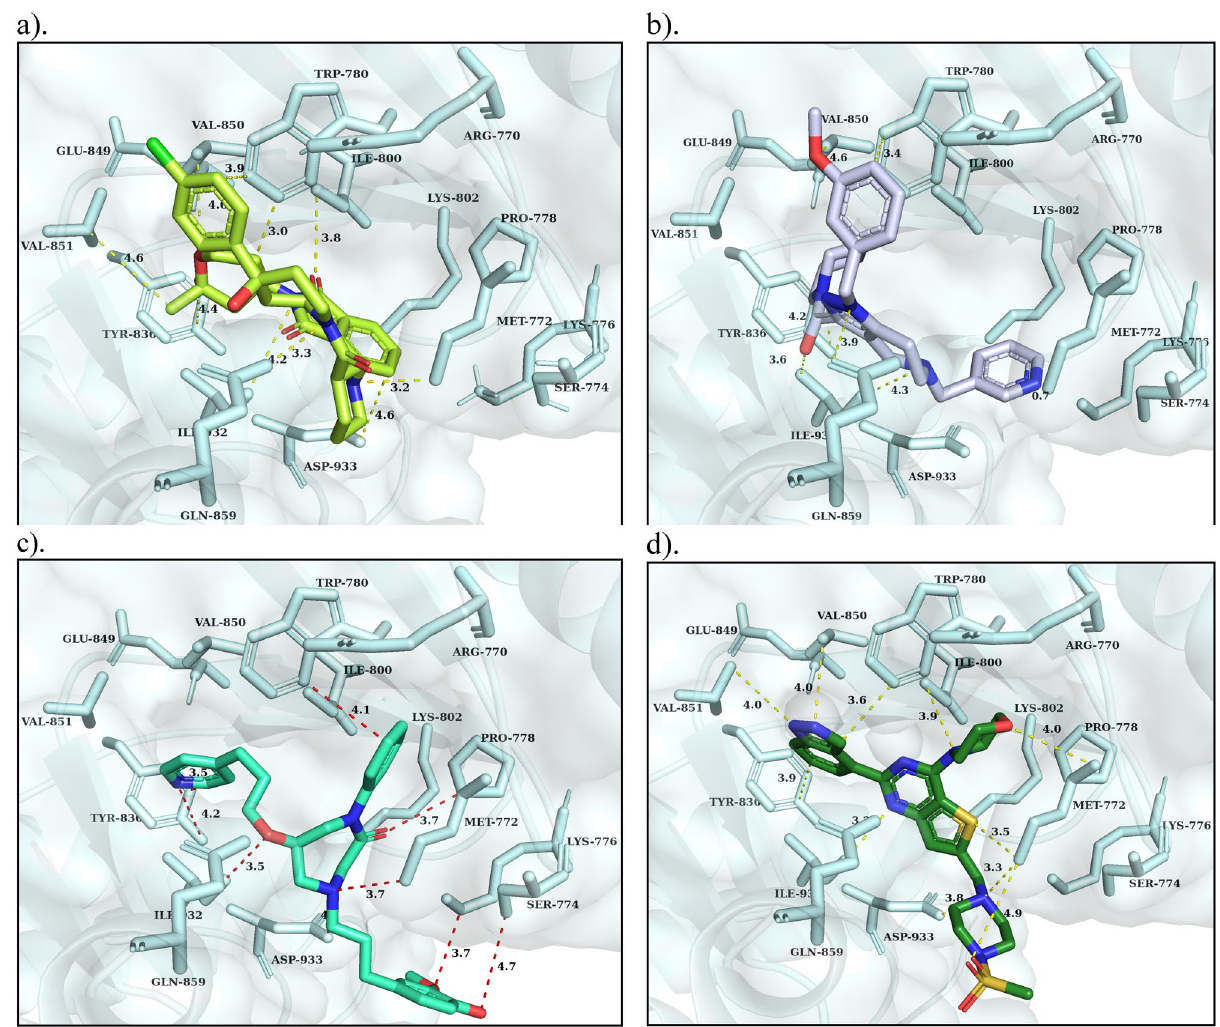
Figure 7. . Binding mode, interactions of (a) Compound-1, (b) Compound-2, (c) Compound-3 and (d) Pictilisib (GDC-0941 (reference inhibitor)) at the ATP binding pocket of PI3K-α. The protein (cyan) is shown in the cartoon with the surface model, the active site residues are indicated in sticks with labeling and the binding interactions are indicated in red dotted lines with distances